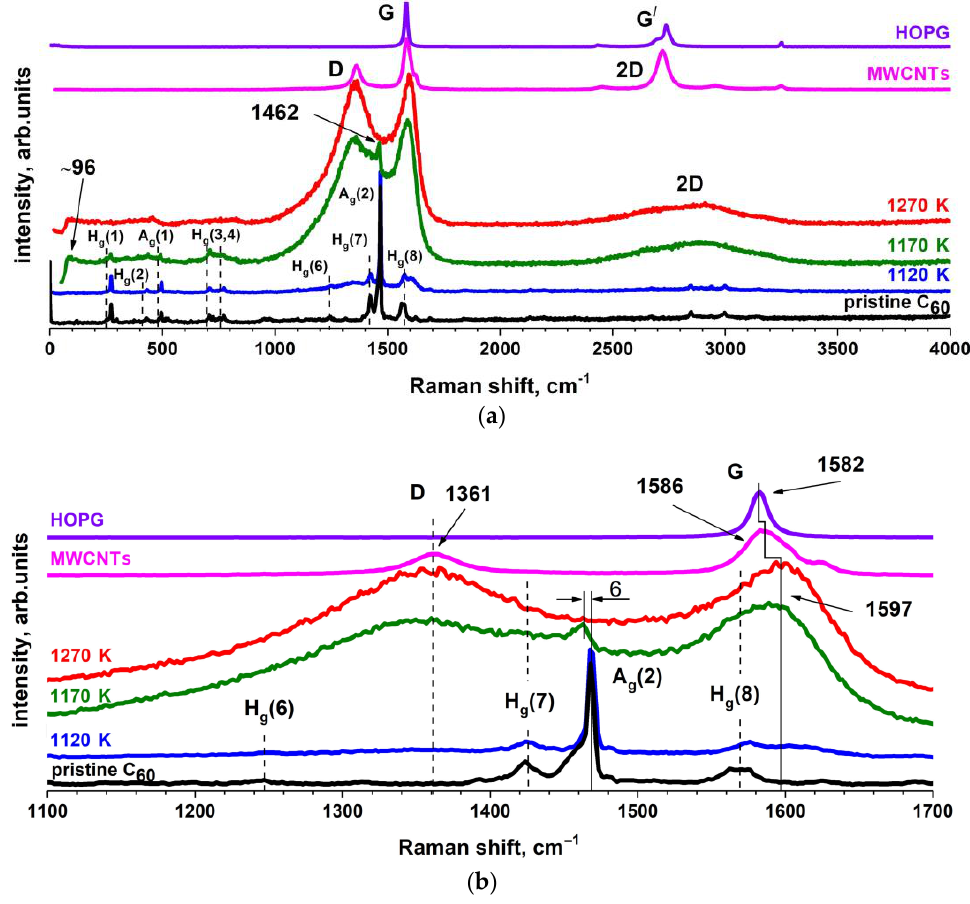
Figure 3. Raman spectra of the HOPG, MWCNTs, pristine and HIP-treated at different temperatures fullerite C 60 over a wide spectral range ( a ) and in the region of 1100–1700 cm -1 ( b ).